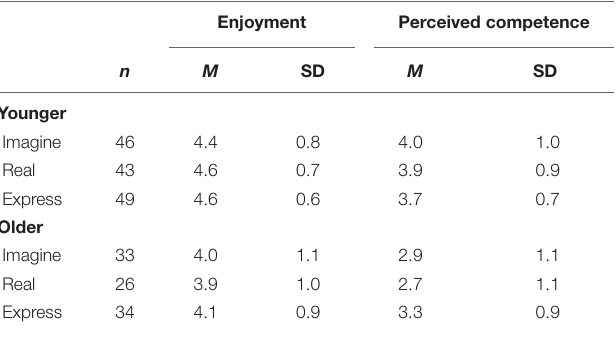
TABLE 4 | Means and standard deviations for enjoyment and perceived competence by condition and age